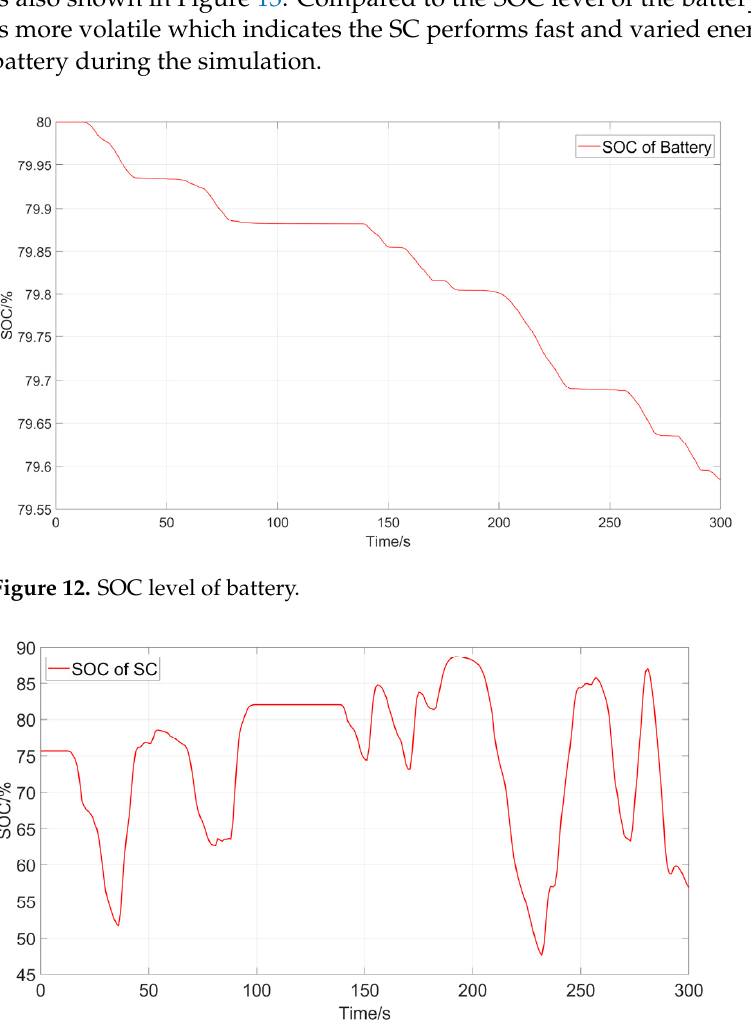
Figure 13. SOC level of SC.